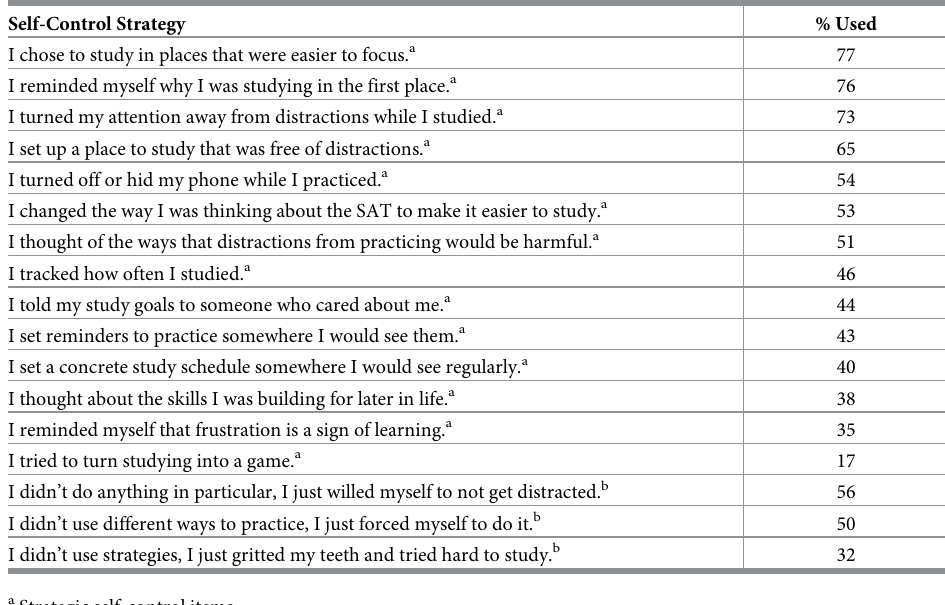
Table 2. Study 2 individual self-control